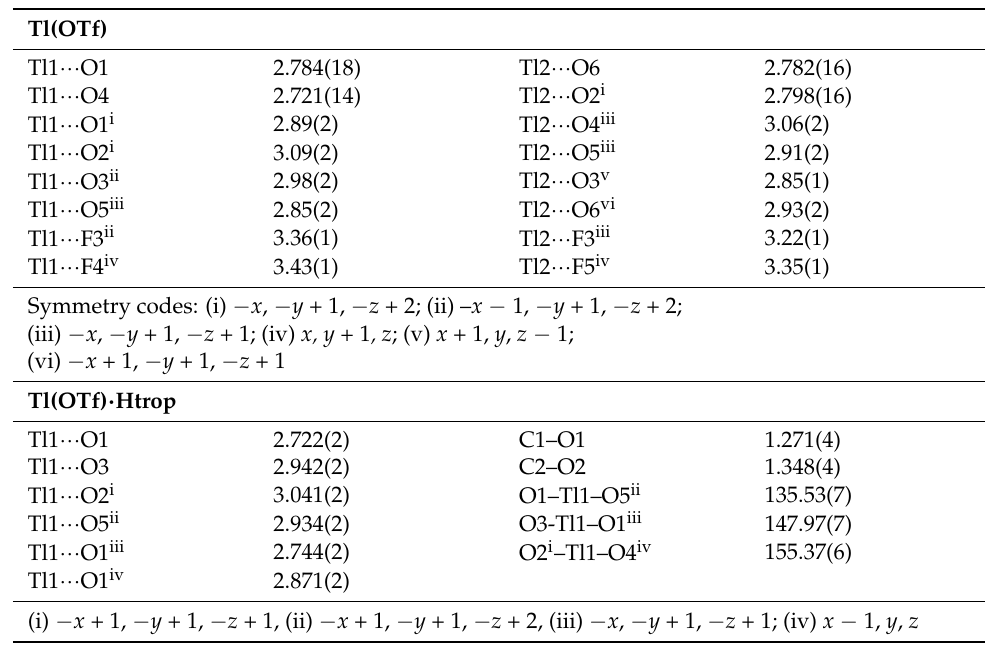
Figure 1. A fragment of the crystal structure of thallium(I) triflate showing the near surroundings around thallium(I) ions (atoms, except for O3–O6 and C1, shown as 50% ellipsoids). Table 1. Selected bond lengths, distances (Å), and angles (°) for thallium(I) triflate and its adduct with tropolone.